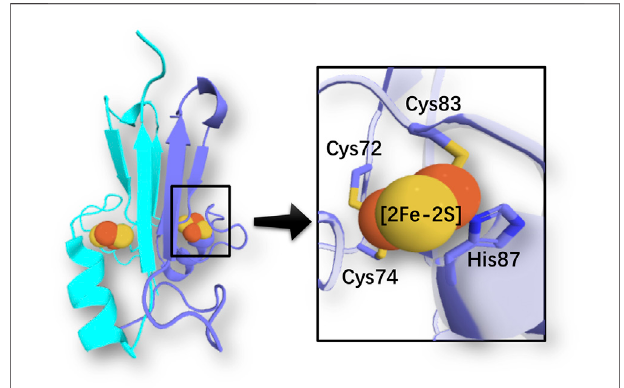
FIGURE 1 | Coordination of an iron-sulfur cluster in a member of the NEET protein family (PDB ID: 2QH7 (Paddock et al., 2007)). Cartoon representation of chain A (light blue) and B (cyan). Sulfur and iron atoms are represented by yellow and orange spheres,